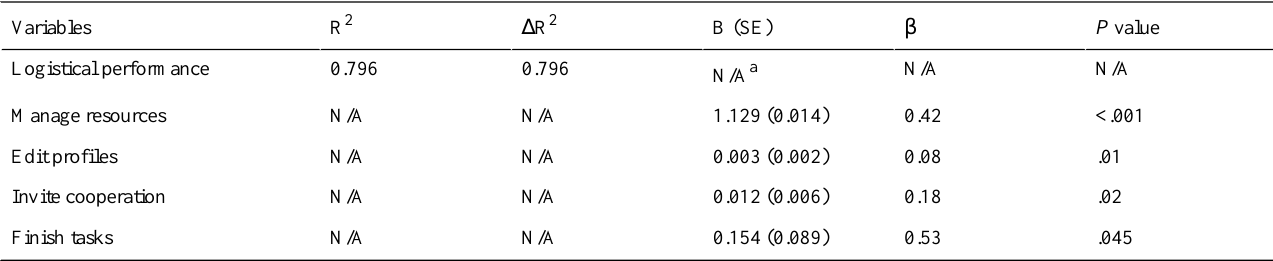
Table 3. Regression analyses predicting logistical performance based on attributes of learning engagement in the board game case